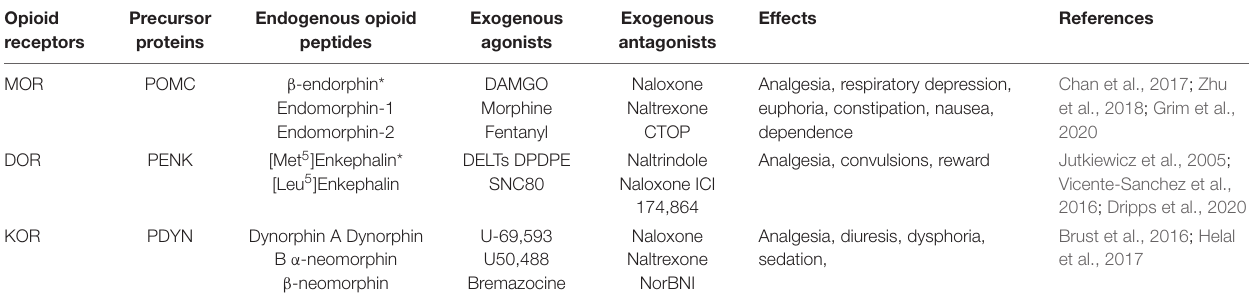
TABLE 1 | Characterization of the opioid